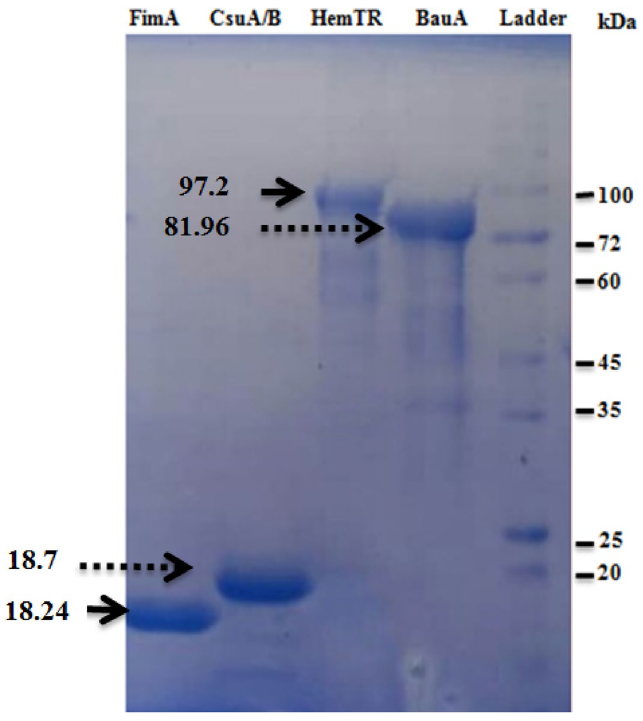
Figure 3. Sodium dodecyl sulfate–polyacrylamide gel electrophoresis (12%) analysis of recombinant proteins. Recombinant proteins containing His-tagged residues were expressed in E. coli BL21 (DE3), followed by purification by affinity chromatography using an Ni–NTA agarose matrix. Purity was evaluated by SDS-PAGE and Coomassie blue